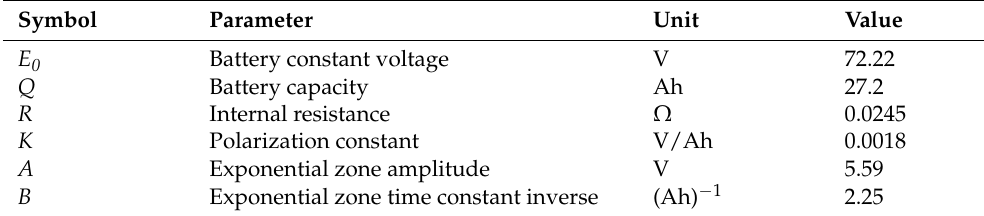
Table 3. Lithium-ion battery